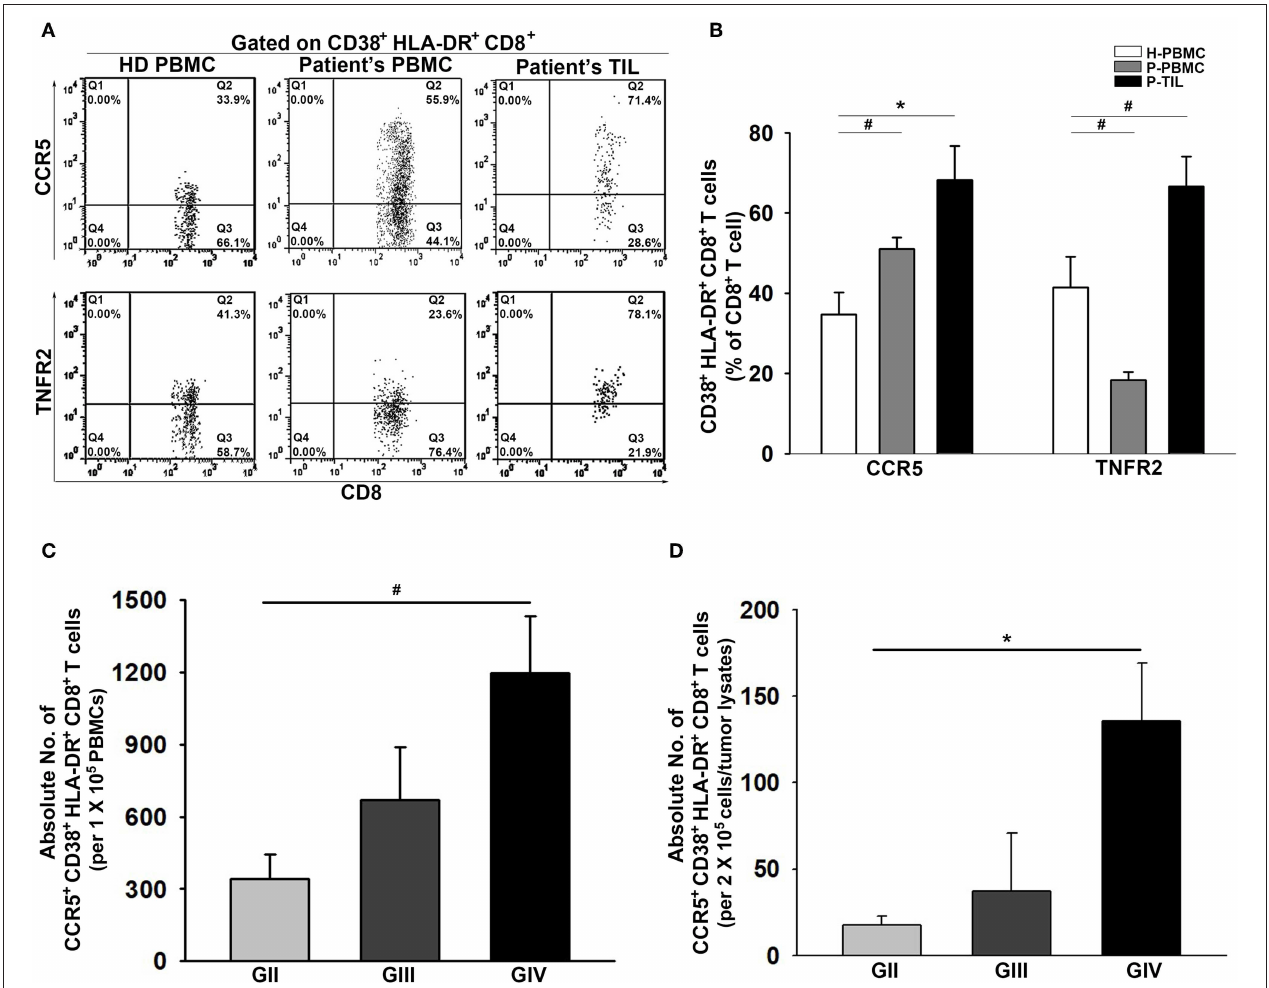
FIGURE 3 | Increased activation of CCR5 and TNFR2 on CD38 + HLA-DR + CD8 + TILs. (A) Representative images of percent expression of CCR5 and TNFR2 on CD38 + HLA-DR + CD8 + T cells for HD PBMCs ( n = 31), Patient PBMCs ( n = 117), and Patient TILs ( n = 17). (B) The percentage expression of CCR5 and TNFR2 on CD38 + HLA-DR + CD8 + T cells were quantified. CCR5 and TNFR2 activation were inversely displayed on the patients’ peripheral CD38 + HLA-DR + CD8 + T cells; increased activation of CCR5 and TNFR2 on CD38 + HLA-DR + CD8 + TILs. (C,D) Numbers of activated CCR5 + CD38 + HLA-DR + CD8 + T cells in the PBMCs and the gliomas of GII, GIII, and GIV were quantified. Values shown are means ± SEM (bars); * p < 0.05, # p < 0.01 by Student’s t-